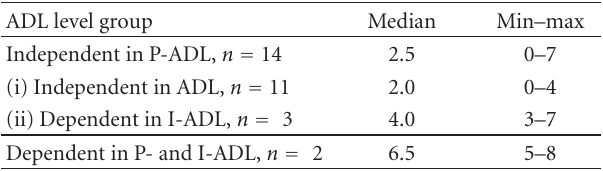
Table 4: Median number of health risks identified in the pilot study, according to ADL level group, N =